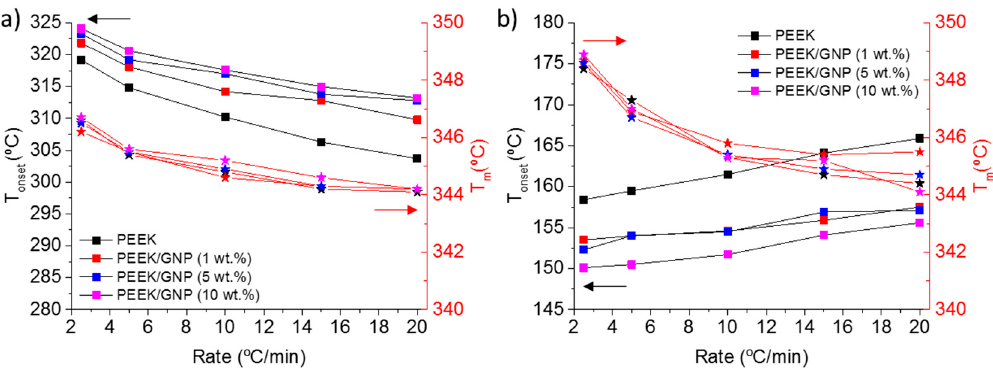
Figure 5. Crystallization temperature onset (square symbols) and melting temperature (star symbols) against cooling ( a ) and heating rate ( b ).